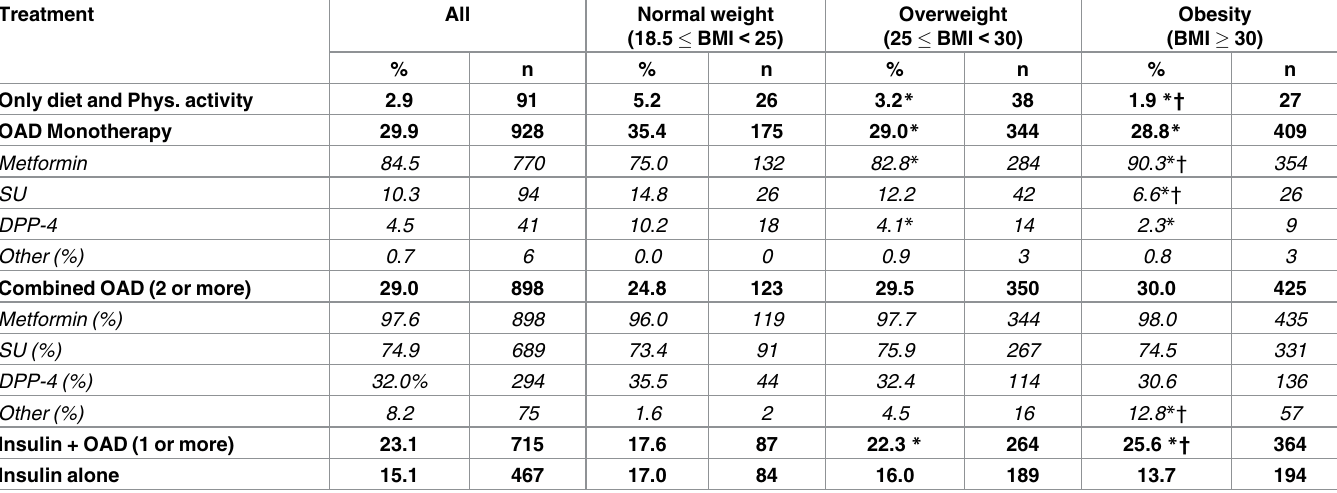
Table 2. Type of hyperglycemia medications treatment by BMI categories . Treatment All